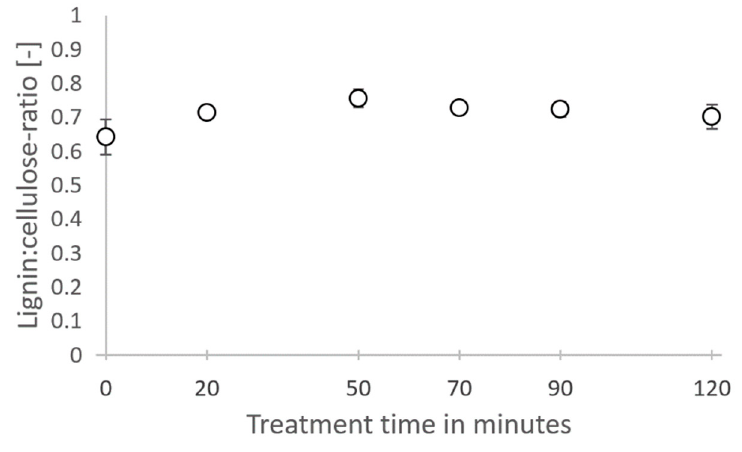
Figure A2. Lignin to cellulose ratio in washed digestate after steam treatment with different treat- ment times.